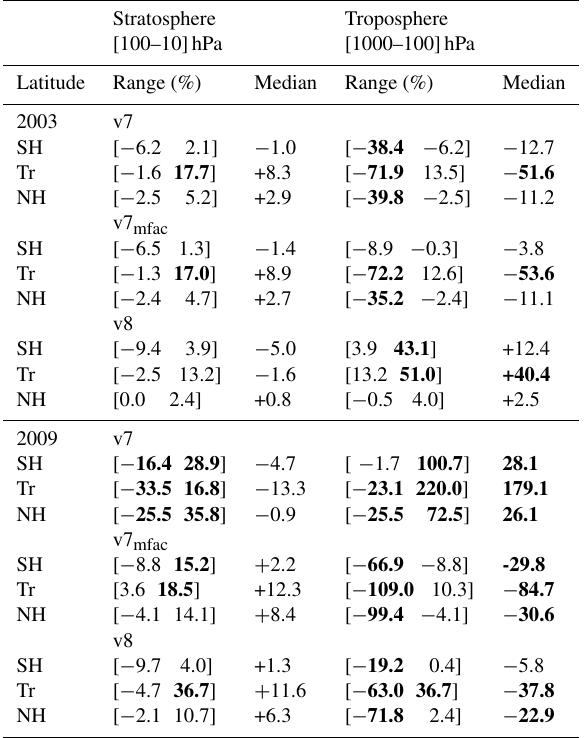
Column 1: Year followed by the latitude zones: Southern Hemisphere (SH), tropics (Tr) and Northern Hemisphere (NH). Column 2: [minimum maximum] of relative differences D a opera − a sonde E ( % ) in the stratosphere for each latitude zone; i.e. minimum corresponds a sonde to the minimum deviation in the retrieved sublayers and correspondingly maximum refers to the maximum deviation in the retrieved sublayers. Column 3: medians of relative difference between retrieved and sonde profiles for stratosphere for SH, Tr and NH over the specified altitude range and for the corresponding latitude band. Column 4 and 5: same as Columns 2 and 3, respectively, but for the troposphere.